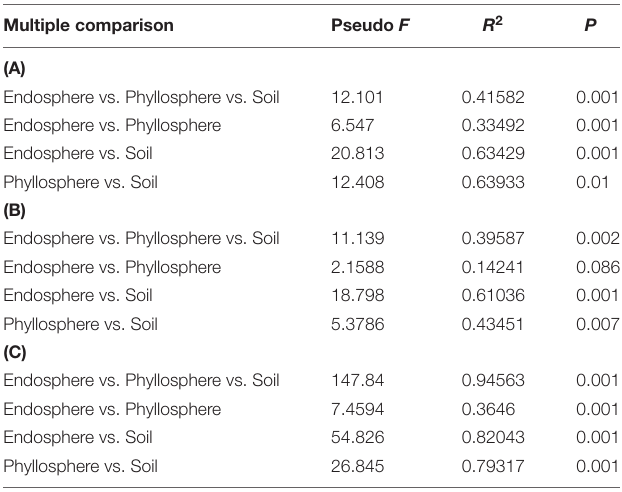
TABLE 2 | Permutational multivariate analyses of variation of the compositional dissimilarity among habitats. Multiple